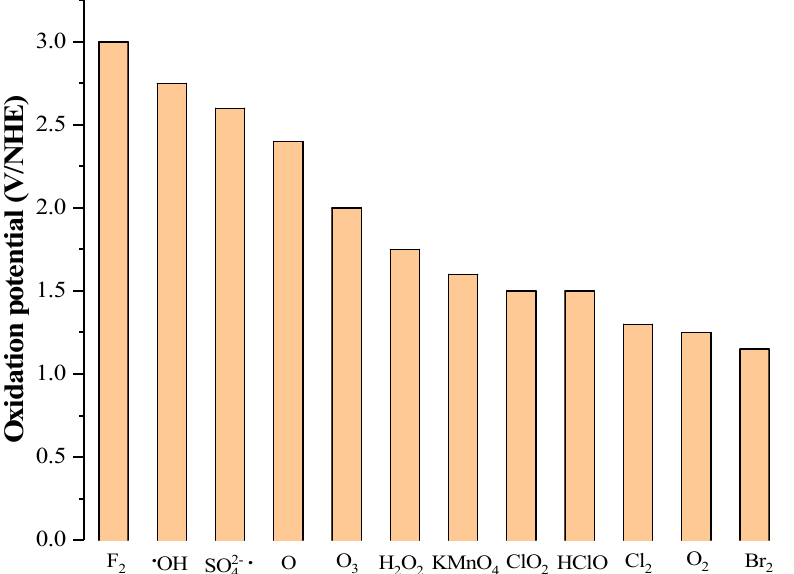
Figure 2. Standard oxidation potentials of common oxidants [58,59].